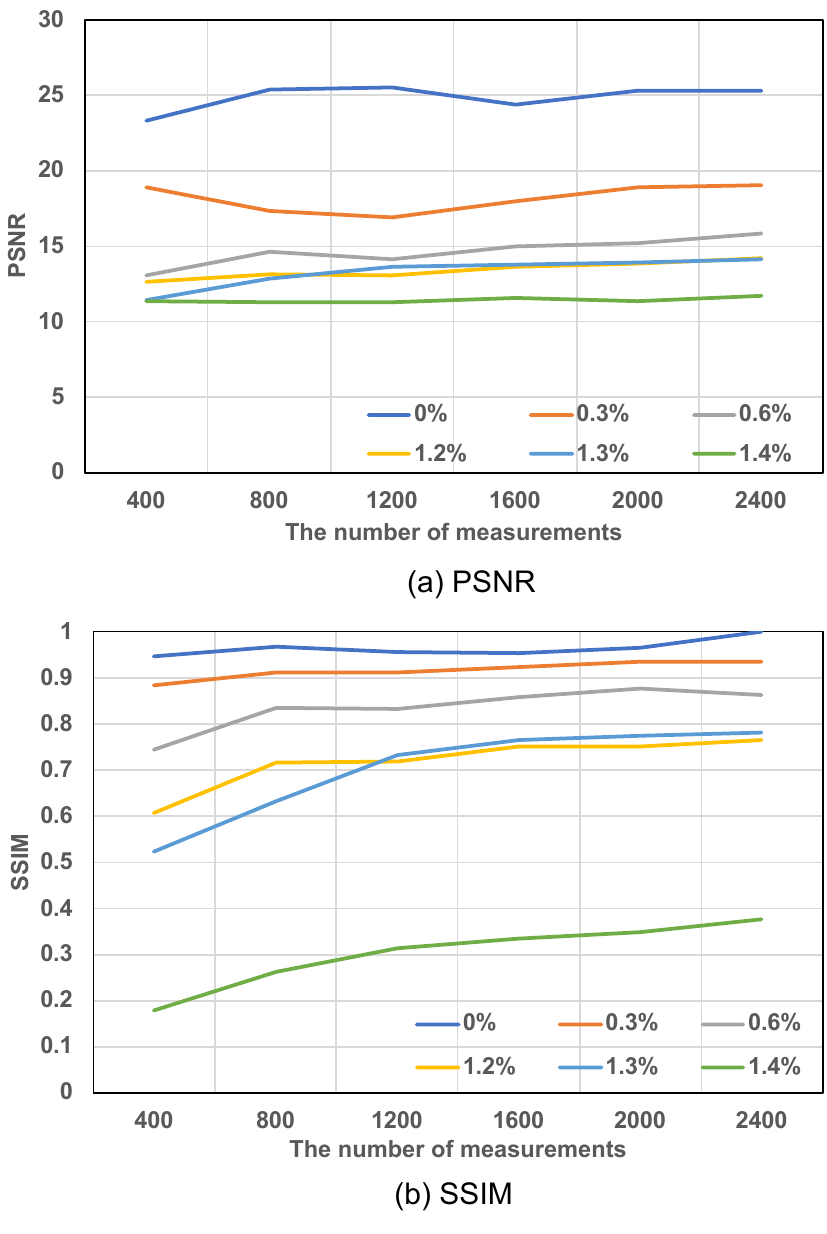
Figure 6. Calculation results of reconstruction images with PSNR and SSIM: ( a ) the PSNR results for 400 ∼ 2400 measurements and 0.0%, 0.3%, 0.6%, 1.2%, 1.3%, and 1.4% concentrations and ( b ) the SSIM results for 400 ∼ 2400 measurements and 0.0%, 0.3%, 0.6%, 1.2%, 1.3%, and 1.4%